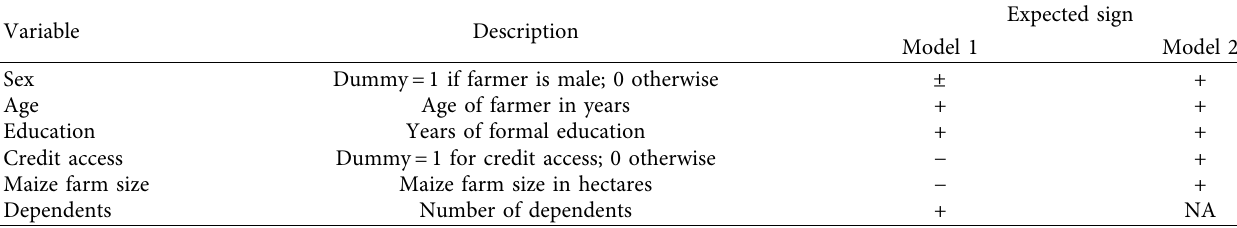
Table 1: Description and expected signs of the explanatory variables included in the analysis.